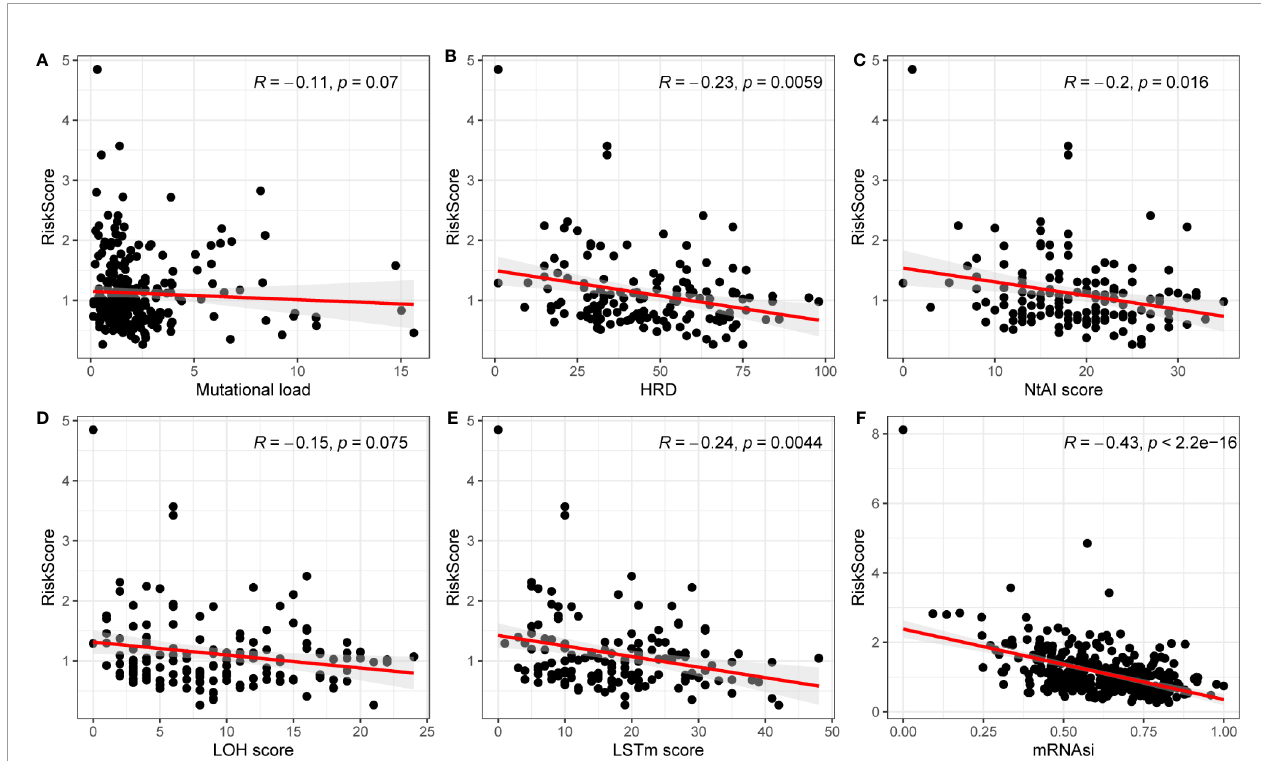
FIGURE 5 | Correlations between mutation load, HRD, NtAI score, LOH score, LSTm score, mRNAsi and risk model. (A) Mutation load; (B) HRD; (C) NtAI score; (D) LOH score; (E) LSTm score; (F)